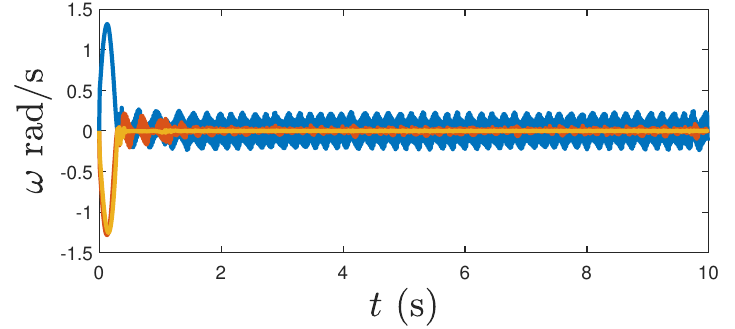
Figure 10. Angular velocity tracking error versus time for PD-type controller of [44].